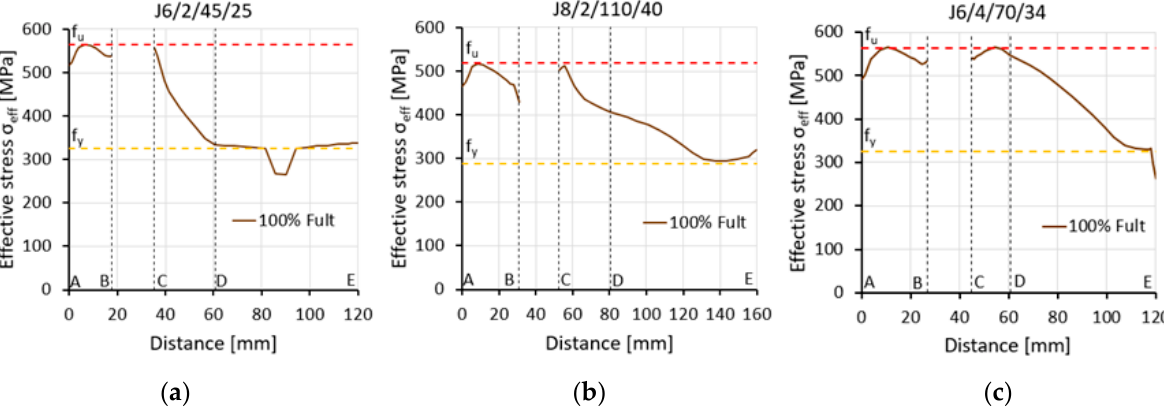
Figure 16. Effective stress distribution in net cross section A net (line A–D) for elements with various failure modes: ( a ) specimen J6/2/45/25 (limited block tearing); ( b ) specimen J8/2/110/40 (block tearing); ( c ) specimen J6/4/70/34 (net section tearing).